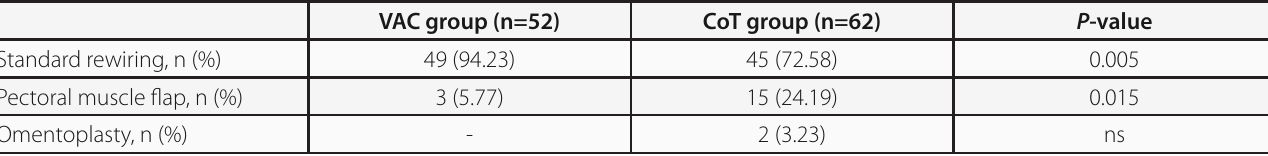
Table 7. Additional surgical wound-healing procedures for post-sternotomy mediastinitis. VAC group (n=52) CoT group